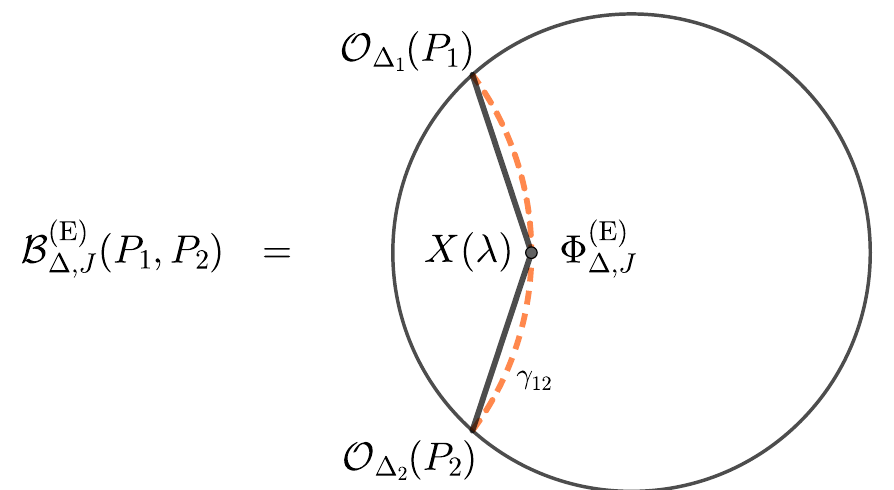
Figure 1 . The holographic description of the OPE block. The orange dashed curve represents the bulk geodesic (cid:13) 12 connecting the boundary points P 1 and P 2 , on which the spinning bulk (cid:12)eld (cid:8) (E) is smeared. The black lines are the scalar bulk to boundary propagators K on the